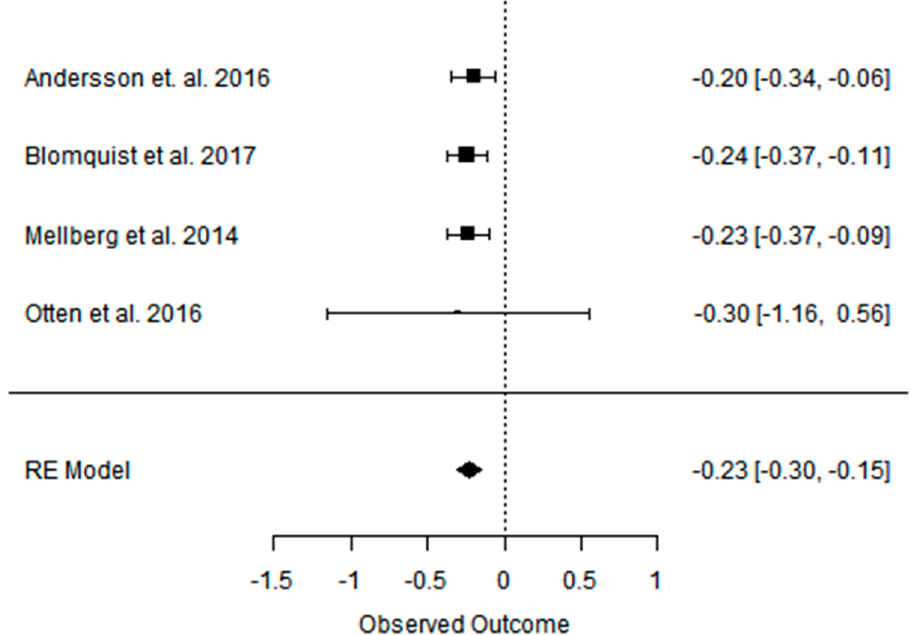
Figure A28. Forest plot of the effect of a PD on TG in the long term (weighted mean difference).